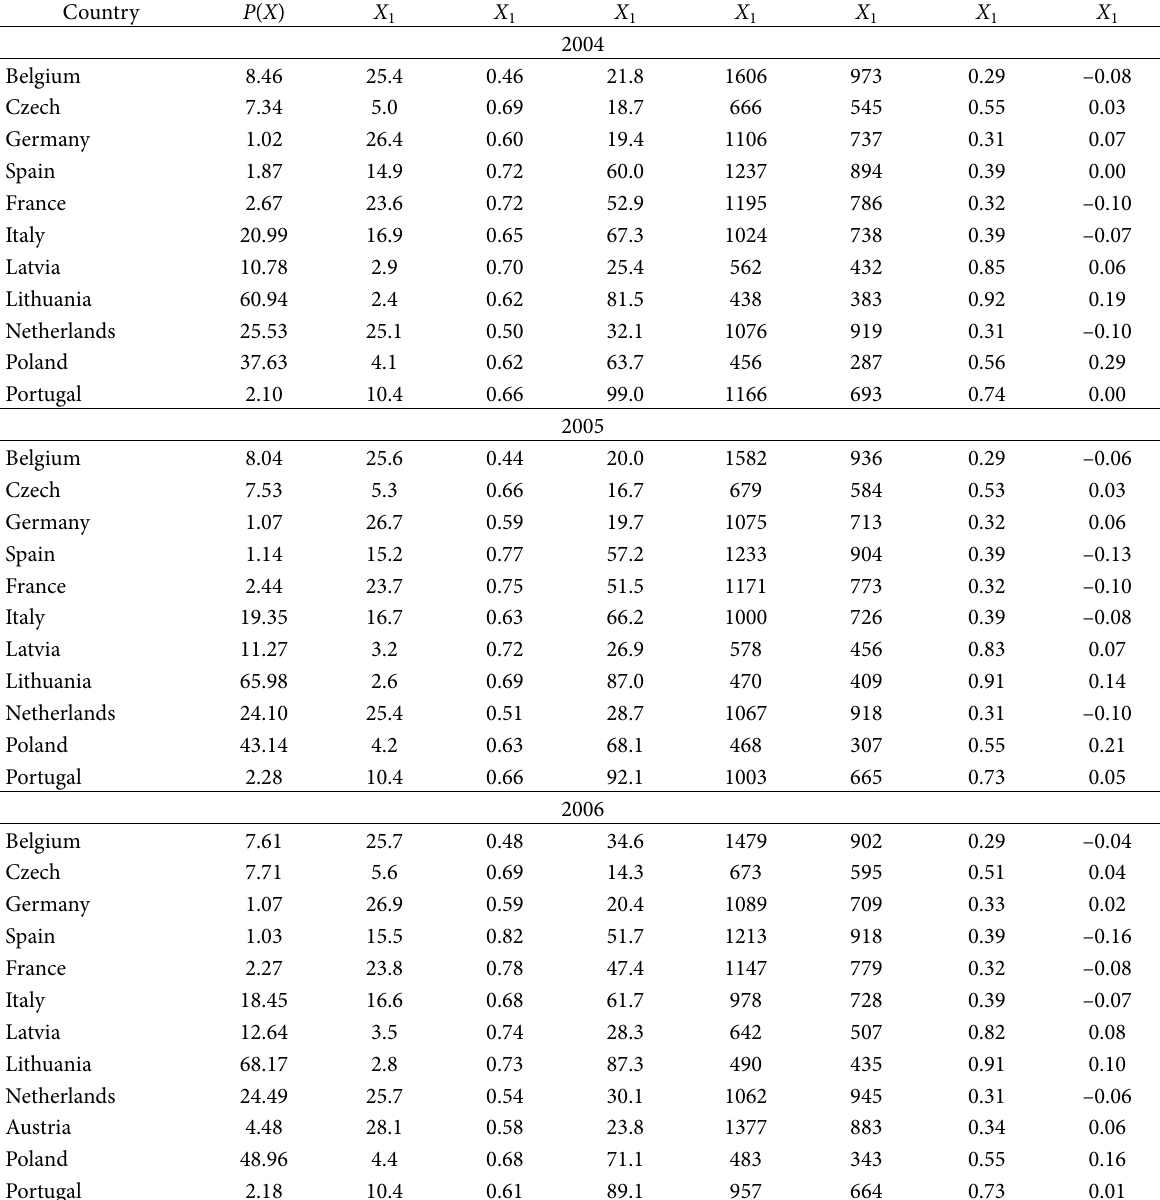
Table 1. Data on using LPG in the road transport of the EU countries for regression analysis